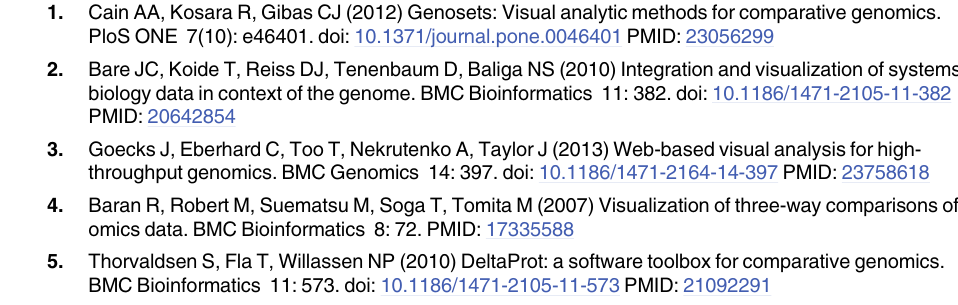
S1 Fig. Labeled Classic Venn diagram. This is an example of a labeled Classic Venn diagram with 5 sets. S2 Fig. Labeled Edwards ’ Venn diagram. This is an example of labeled Edwards ’ Venn dia- gram with 5 sets. S3 Fig. Labeled Nested Venn diagram. This is an example of labeled Nested Venn diagram with 5 sets. S4 Fig. Nested Venn with eight data sets. Example from the goldfish x common carp hybrid system with Nested Venn. The right smaller diagram in the green rectangle shows uniquely shared sets only among four datasets (f18, f22-1, f22-2, f22-3), while the larger left diagram includes all eight shared relationships by inlaying the right four into every intersection area showing another unique shared set among datasets for R ♀ , C ♂ , f1 and f2. For example, the number in the red rectangle, 53, which is over R ♀ and f18, means that R ♀ and f1 shared 53 items only. The Nested Venn diagram shows that each sample has more than 200 unique genes and all samples share 27,681 genes. Data sets are from Liu et al. (2016) [37]. S1 Table. GFF file